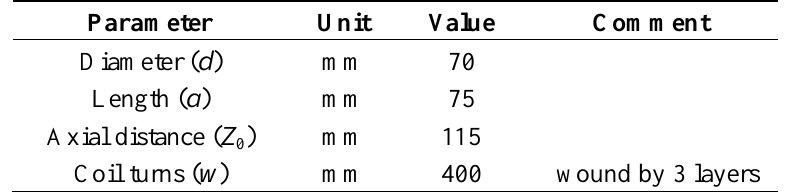
Table 1. Geometrical parameters of Solenoids I and II for the proposed H-type